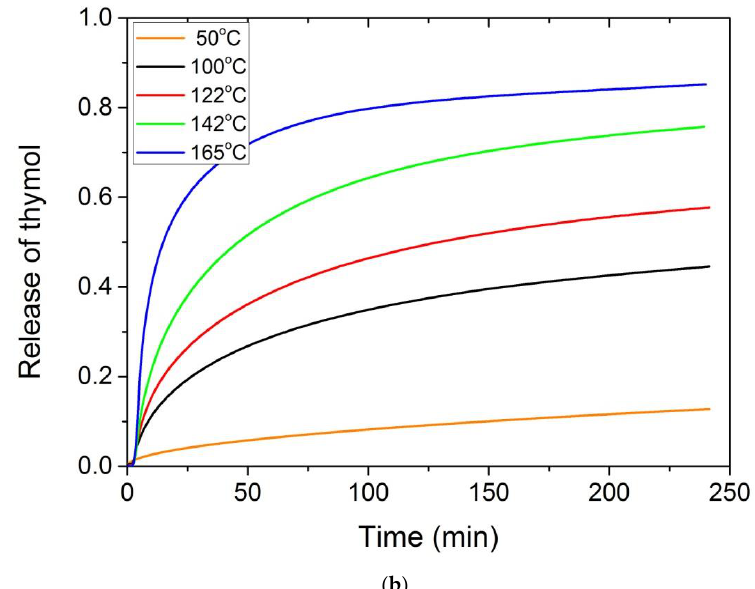
Figure 9. Release profiles of carvacrol ( a ) or thymol ( b ) from the polymer matrix at five different temperatures, 50, 100, 122, 144 and 165 °C. Measurements were carried out isothermally using TGA.